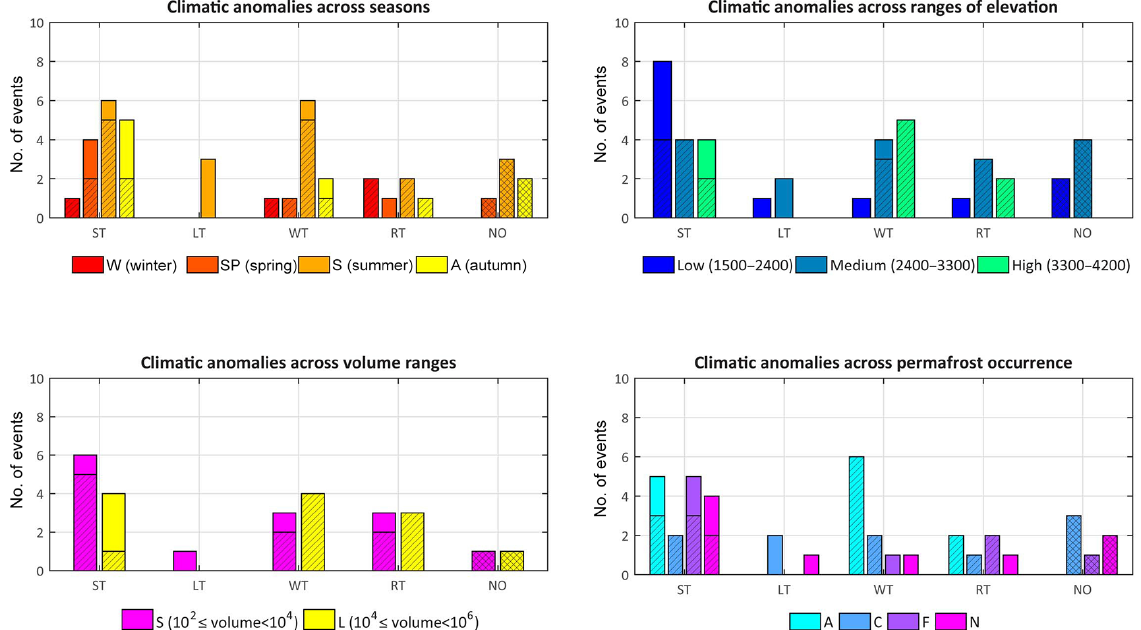
Figure 3. Distribution of rockfalls according to the type of climate anomaly, and considering (a) the season of occurrence, i.e. W (winter), SP (spring), S (summer), A (autumn); (b) the elevation, i.e. low (1500–2400m), medium (2400–3300m), high (3300–4200m); (c) rockfall volume, i.e. small-volume events (S, 10 2 ≤ volume<10 4 m 3 ) , large-volume events (L, 10 4 ≤ volume<10 6 m 3 ) ; (d) expected permafrost occurrence in the detachment zone, i.e. A (permafrost in nearly all conditions), C (mostly in cold conditions), F (only in very favourable conditions), N (no permafrost). Climate anomaly groups: ST is short-term temperature anomaly; LT is long-term temperature anomaly; WT is widespread temperature anomaly; R is precipitation anomaly (at the weekly range or longer) without or in association to temperature anomalies; NO indicates no anomaly. Warm T anomalies are highlighted with a striped